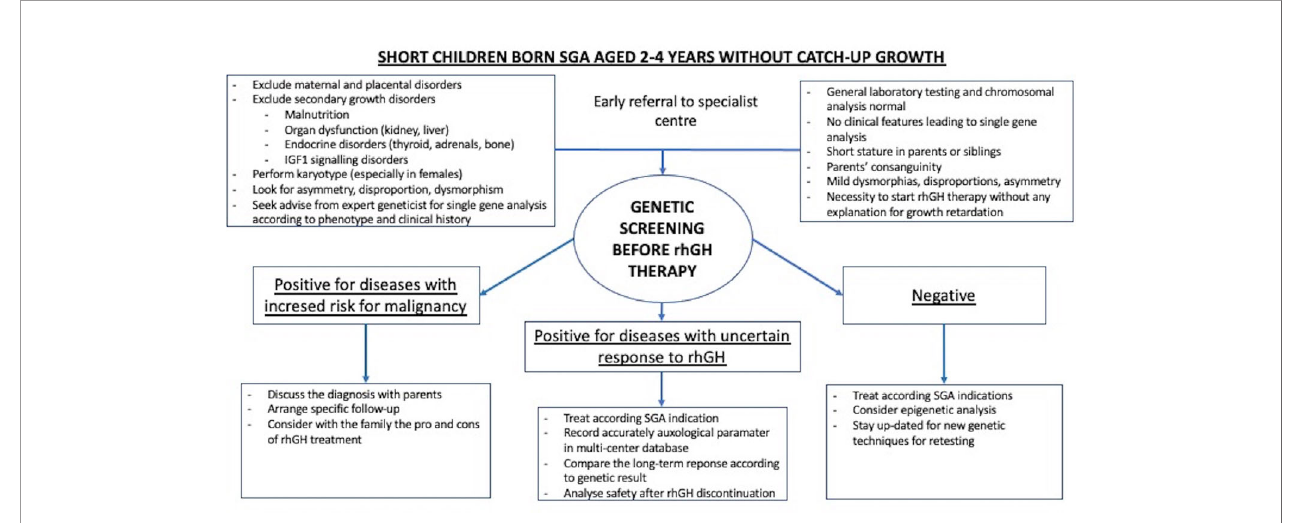
FIGURE 1 | Example of genetic screening strategy included in the work-up and treatment of children born SGA with persistent short stature.